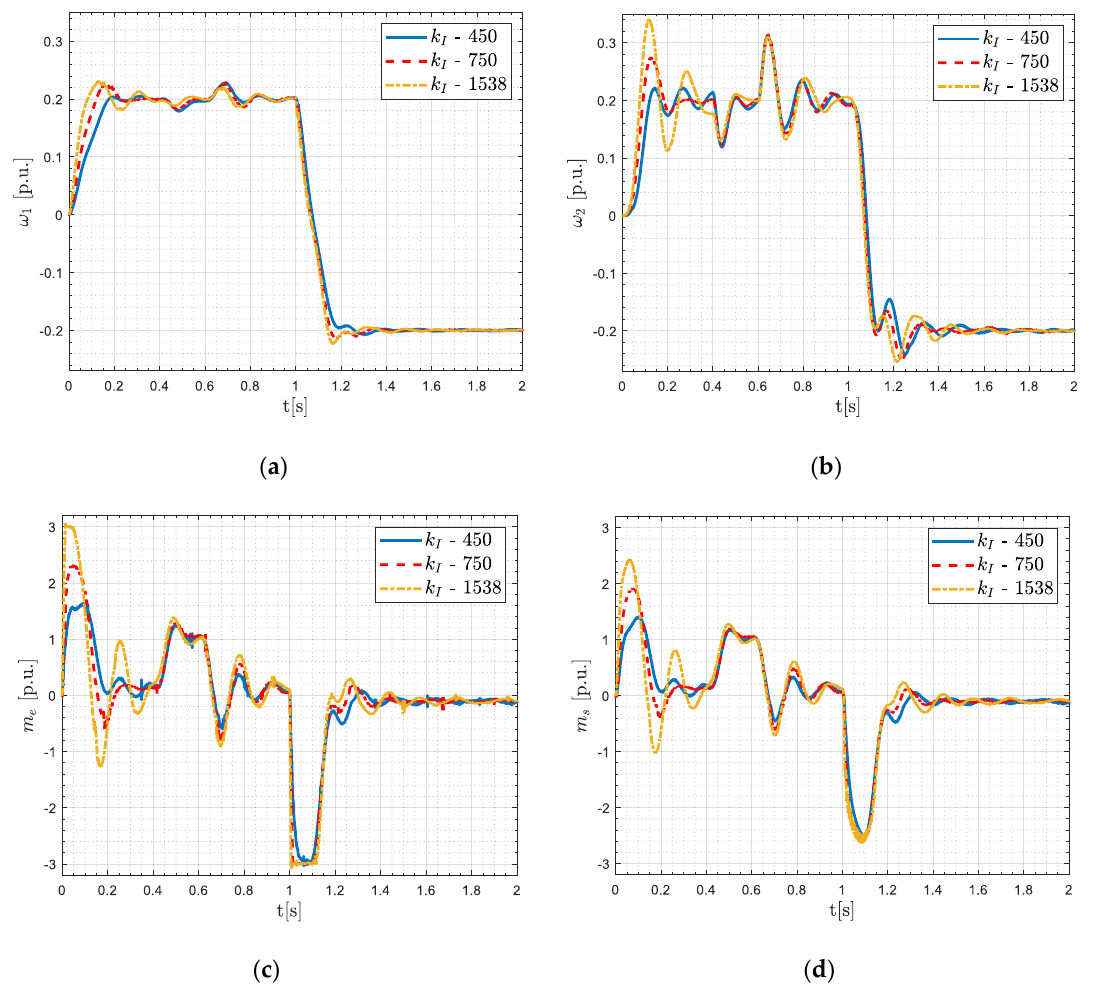
Figure 13. Experimental transients of the two-mass system: motor speed ( a ), load speed ( b ), electromagnetic torque ( c ), and shaft torque ( d ) for different gains of the speed controller and value of the reference signal equal to 0.2 for R = 0.25.